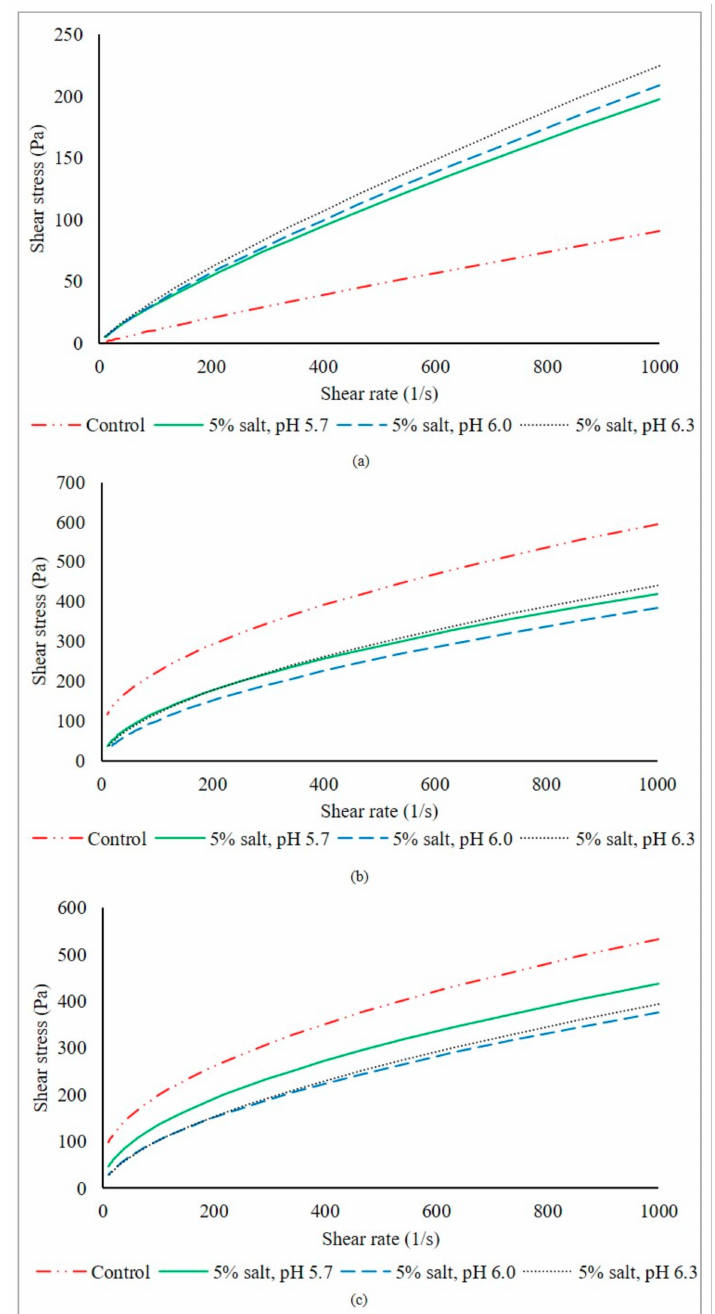
Figure 9. Flow curves of liquid egg yolk samples before freezing ( a ), and frozen-thawed liquid after 14 days ( b ) and 28 days ( c ) of storage at − 18 ◦